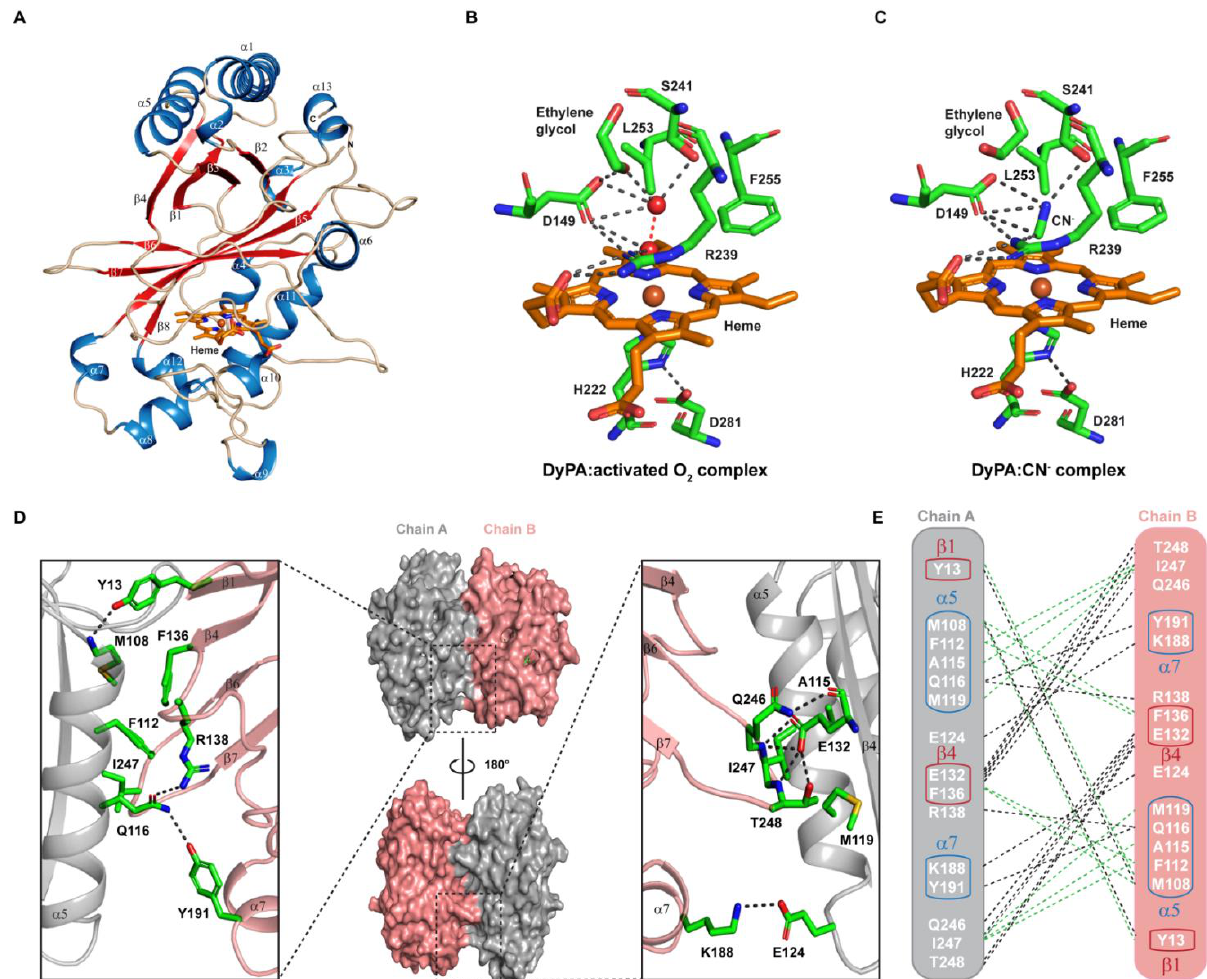
Figure 6. Structure of Dictyostelium DyPA. ( A ) Cartoon representation of the overall fold of Dictyostelium DyPA monomer and the heme-binding site. α -helices and β -strands are numbered in order from N to C-terminal. α -helices, β -strands, and loops are colored in sky blue, red, and wheat, respectively. Heme prosthetic group is shown as a stick model. ( B ) The heme microenvironment of Dictyostelium DyPA in complex with an activated oxygen molecule. The atoms of the activated oxygen molecule are shown as red spheres. ( C ) Heme microenvironment of Dictyostelium DyPA-CN − complex. Iron, nitrogen, and oxygen atoms are colored in orange, blue, and red, respectively. Grey dashed lines indicate distances of less than 3.4 Å. ( D ) Dictyostelium DyPA dimer interface. Dictyostelium DyPA monomers are distinguished by the colors grey and salmon pink. The upper panel shows a close-up view of the interface, while the lower panel shows the view after 180 ◦ rotation. ( E ) Schematic representation of residues located at the DyPA dimer interface that contribute to the interaction between monomers A and B. Hydrogen bonds and ionic interactions are shown as black dashed lines and hydrophobic interactions as green dashed lines. In addition, the carboxyl group of Asp146 extends the hydrogen bond network between Dictyostelium DyPA monomers by forming an H-bond contact with Gln116 of another monomer via a water molecule. This interaction provides additional stabilization to the dimer interface of DyPA. Asp146 contributes also indirectly to the stabilization of the dimer interface by affecting the orientation of the side chain of Arg138 in the same monomer (Figure